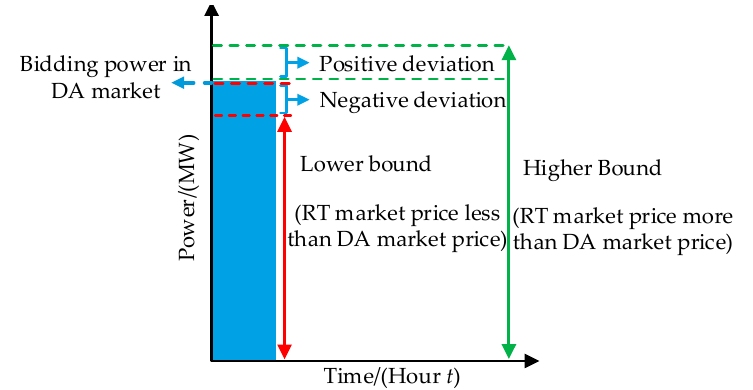
Figure 1. Framework of the user-side over-deviated revenue mechanism (UORM).